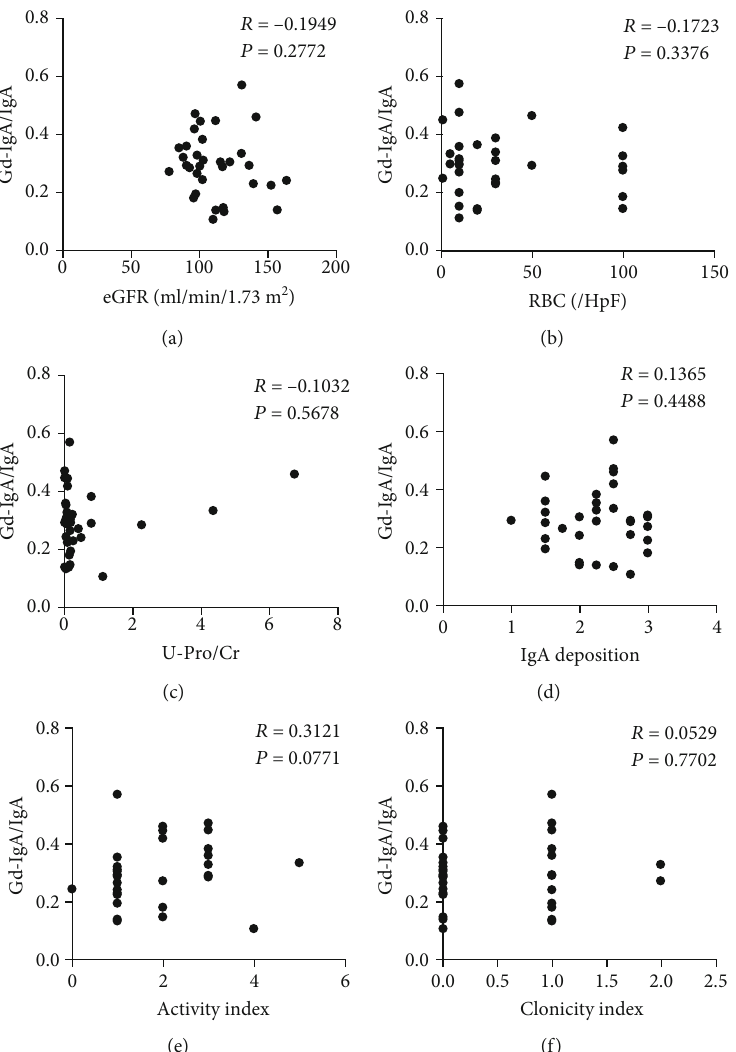
Figure 6: Correlation between the serum Gd-IgA1/total IgA ratio and clinical and histological parameters in patients with IgA nephropathy: (a) eGFR, (b) hematuria, (c) proteinuria, (d) mesangial IgA deposition, (e) activity index, and (f) chronicity index. RBC: red blood cells; HpF: high-power fi eld: U-Pro/Cr: urinary protein to creatinine